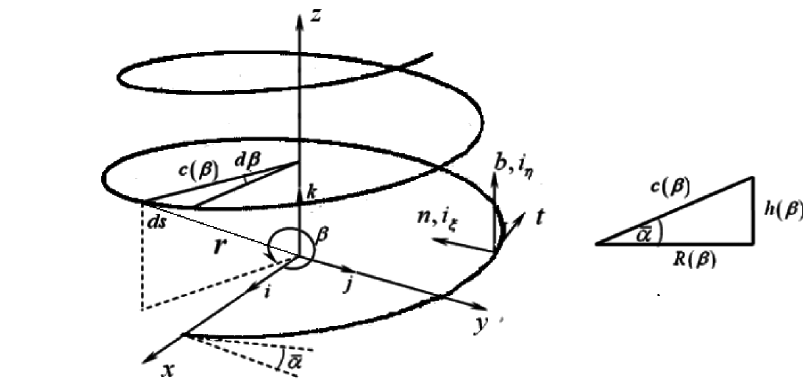
Fig. 1. Geometry of a typical non-cylindrical